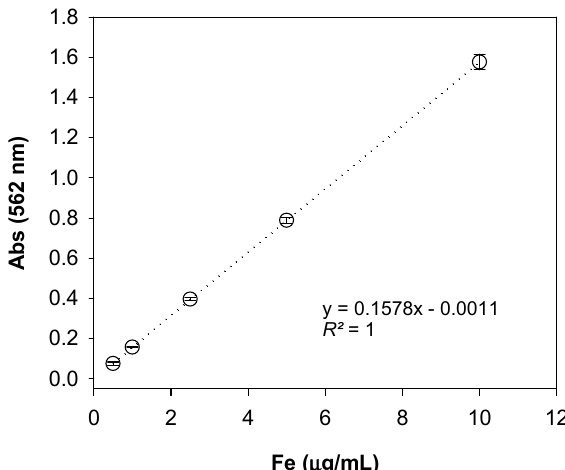
Figure 2. Standard calibration curve of the conventional Ferrozine assay in vitro. Absorbance was measured at 562 nm for varying levels of atomic Fe concentration ( n = 5) and the means ± SD are